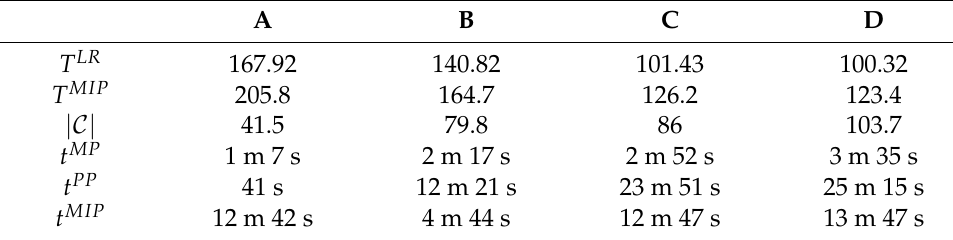
Table 8. Optimization model efficiency-large